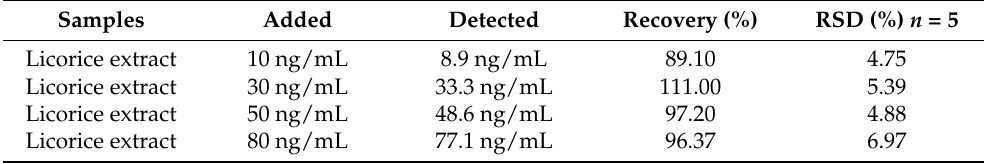
Table 2. Detection of Hg 2+ in licorice extract based on Fe 3 O 4 @SiO 2 @AuNPs-DMcT.